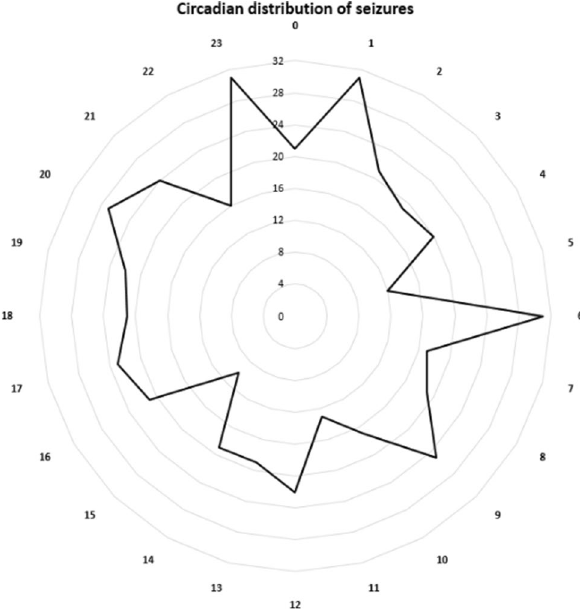
Figure 3. Circadian distribution of seizures.